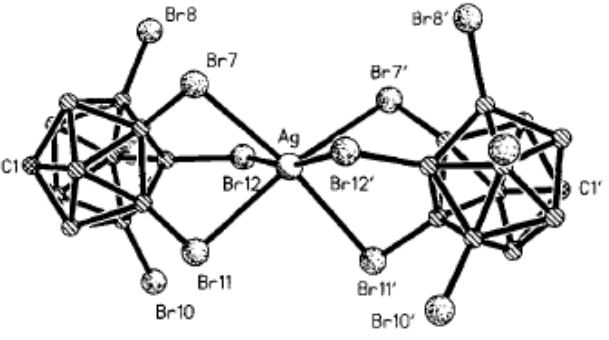
Figure 69. Structure of the {Ag[1-CB 11 H 6 -6,7,8,9,10,11,12-Br 6 ]} − anion in complex [Fe(TPP)]{Ag[1-CB 11 H 6 -6,7,8,9,10,11,12-Br 6 ] 2 }·4( p -xylene). Reproduced with permission from reference [97]. Copyright © (1994) John Wiley & Sons, Inc.